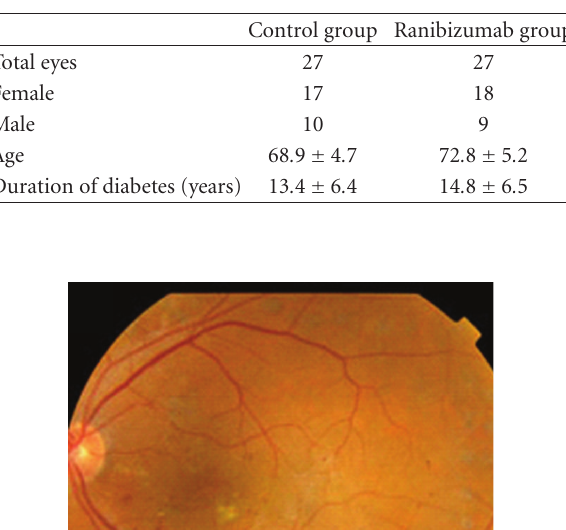
Table 1: Clinical characteristics of patients before the cataract surgery.